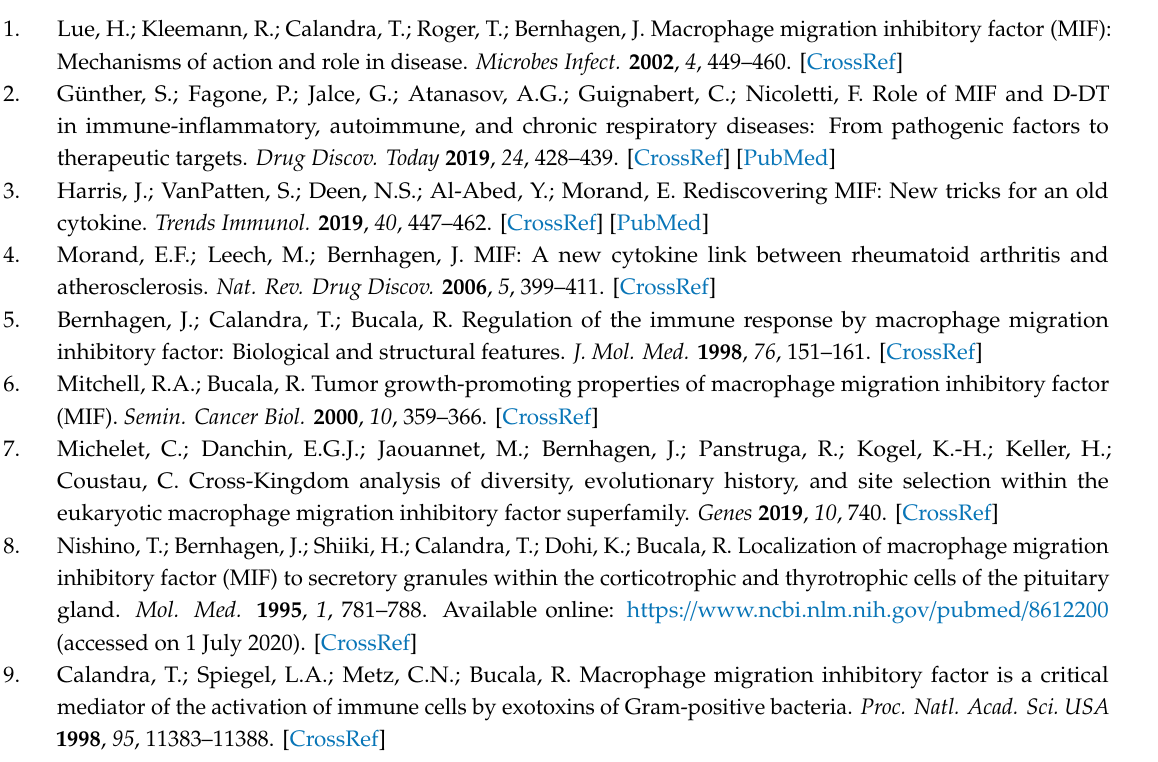
Figure S1: Immunogold-labelled electron micrographs of L. polyedra , Figure S2: Negative control samples of unstressed and stressed L. polyedra , Table S1: Accessions, names and primer sequences for transcripts analyzed in this